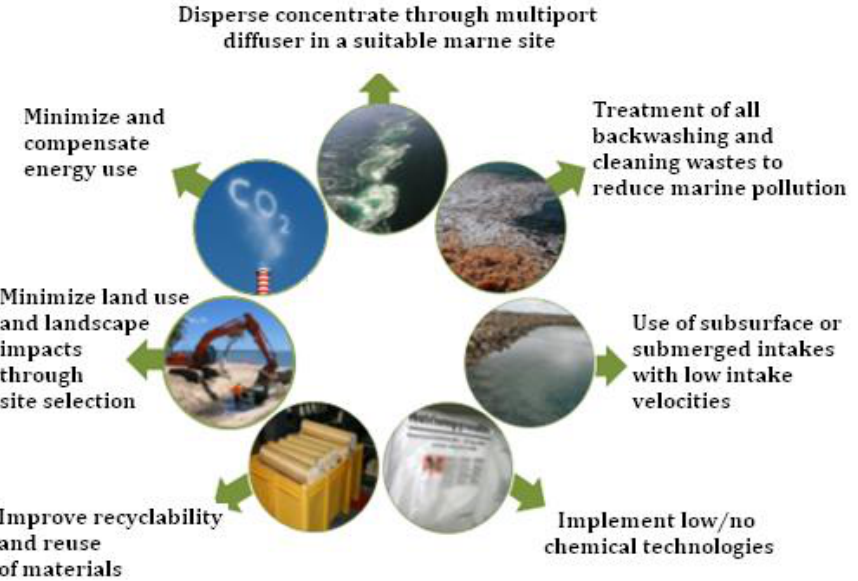
Figure 9. Environmental concerns and sustainable solutions for the desalination plant to minimize the environmental impact [28].